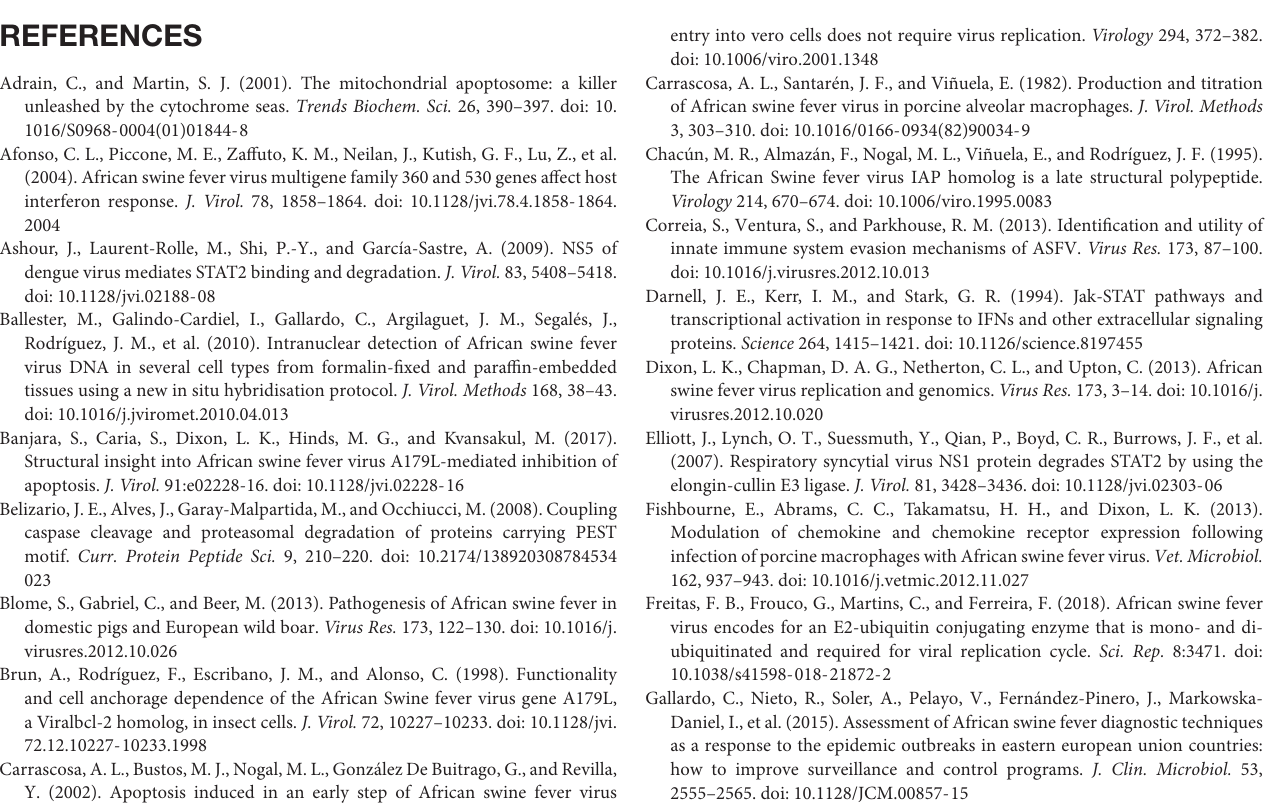
(1,000 U/ml) at 15 hpi, during 1 hour. Antibodies against ISG15 and actin were used. Supplementary Figure 2 | NH/P68 and Arm/07/CBM/c2 strains counteract IRF9/STAT1/STAT2 nuclear translocation at late times of infection. PAMs were mock infected or infected with NH/P68 or Armenia/07/CBM/c2 (Arm) (1 PFU/cell). At 7 or 15 hpi, cells were untreated or treated with universal type I IFN (250 U/ml). After 1 h of treatment, cells were fixed and stained with DAPI (blue), anti-p32 (red) and anti-IRF9, anti-STAT1 or anti-STAT2 (green) antibodies and examined by a confocal microscope. Individual channel images are shown. Supplementary Figure 3 | NH/P68 and Arm/07/CBM/c2 strains inhibits STAT1 and STAT2 phosphorylation at late times of infection. PAMs were mock infected or infected with NH/P68 or Armenia/07/CBM/c2 (Arm) (1 PFU/cell). At 7 or 15 hpi, cells were untreated or treated with universal type I IFN (250 U/ml). After 1 h of treatment, cells were fixed and stained with DAPI (blue), anti-p32 (red), and anti-pSTAT1 or anti-pSTAT2 (green) antibodies and examined by a confocal microscope. Individual channel images are shown. Supplementary Figure 4 | ASFV-induced STAT2 degradation depends on the proteasomal degradation pathway. PAMs were mock infected or infected with attenuated NH/P68 ASFV strain (2 PFU/cell) and treated or not with increasing concentrations of MG132 (1, 5, or 20 µ M) at 12 hpi. At 16 hpi, cells were collected and lysed for the Western blot analysis. Antibodies against STAT2, viral p32 protein and actin were used. Supplementary Figure 5 | STAT1 cleavage is induced by caspase-3 during ASFV infection. PAMs were mock infected or infected with attenuated NH/P68 ASFV strain (2 PFU/cell) in absence or in presence of increasing concentrations of caspase-3 inhibitor Ac-DEVD-CMK (10, 40, or 100 µ M). At 16 hpi, cells were collected and lysed for the Western blot analysis. Antibodies against STAT1, early viral protein p32 and actin were employed. The Western blot bands corresponding to STAT1 α (91 kDa), STAT1 β (84 kDa), and cleaved STAT1 (81kDa) are indicated in the